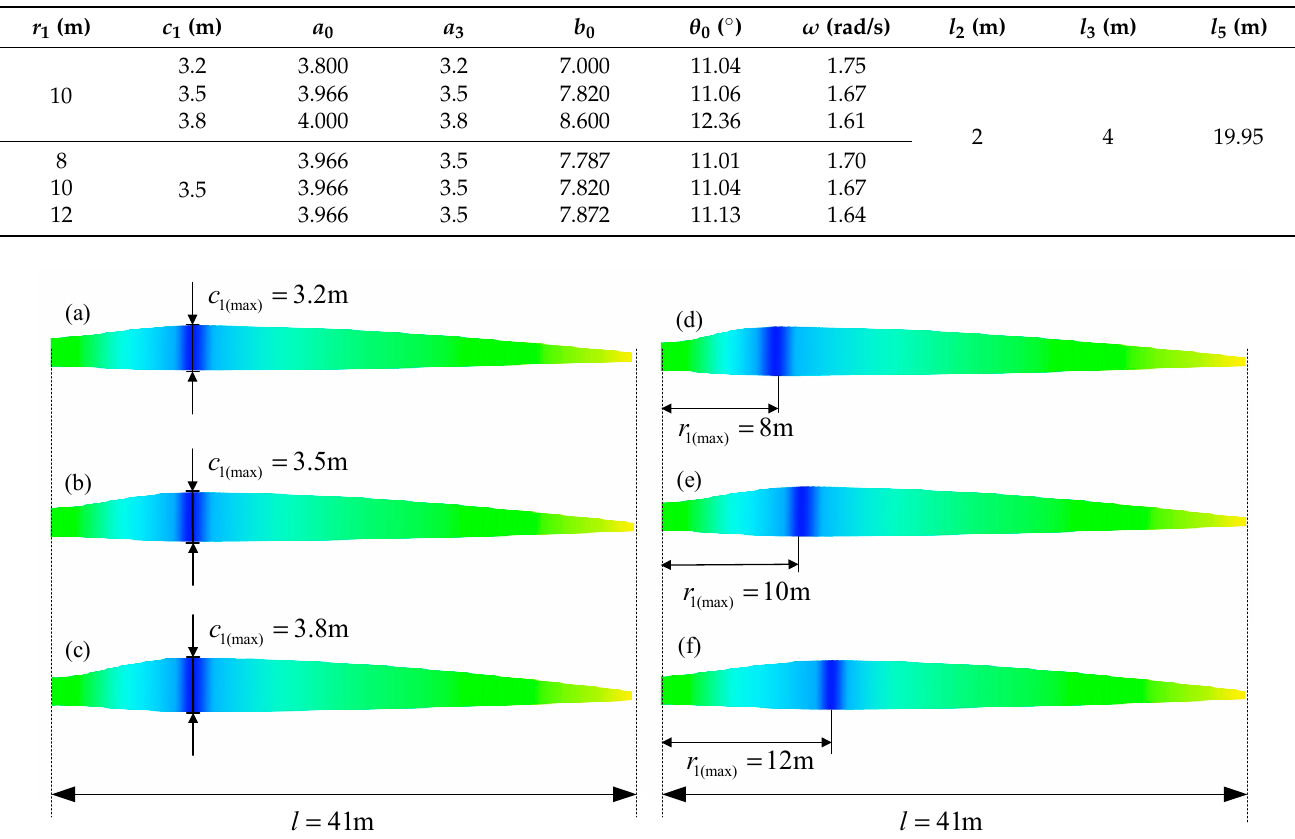
Figure 7. Blades with different maximum chord length values and locations. ( a ) Blade shape with a maximum chord length of 3.2 m; ( b ) Blade shape with maximum chord length of 3.5 m; ( c ) Blade shape with a maximum chord length of 3.8 m; ( d ) Blade shape with maximum chord length position of 8 m; ( e ) Blade shape with maximum chord length position of 10 m; ( f ) Blade shape with maximum chord length position of 12 m. Table 3. The effect of the maximum chord length and its location change.